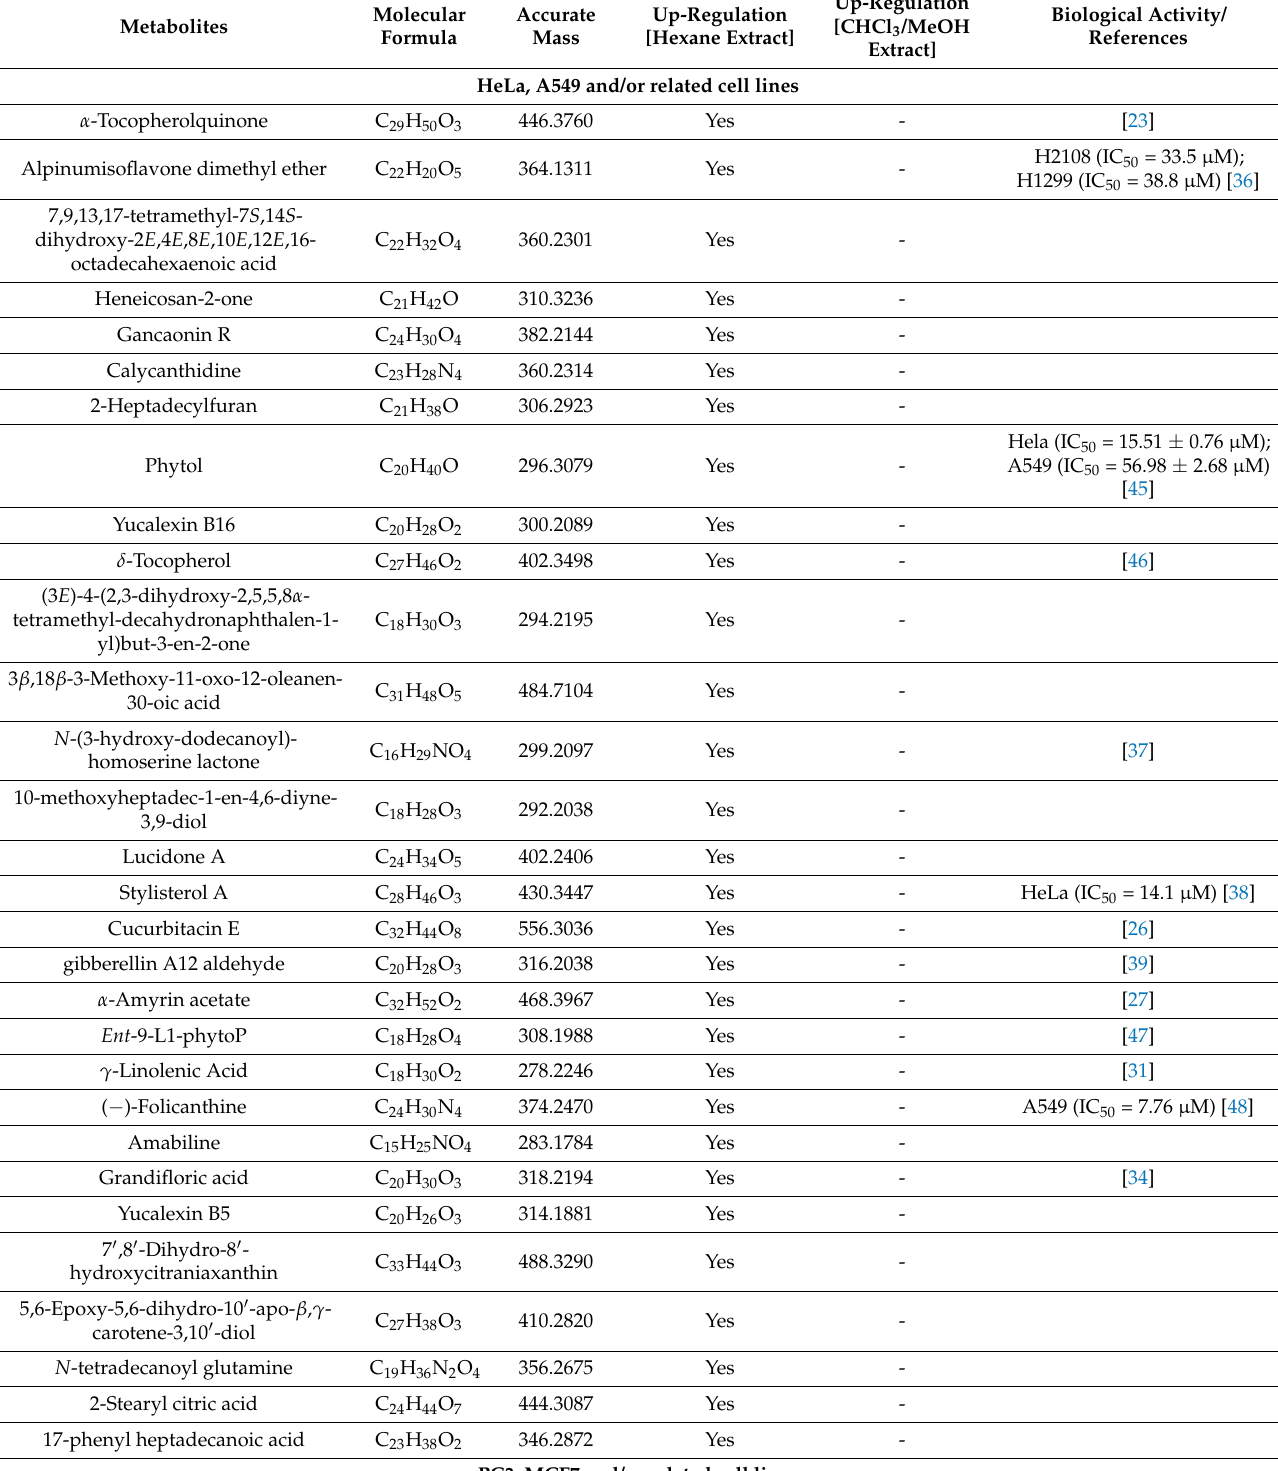
Table 4. Fold change analysis results in the hexane and CHCl 3 /MeOH